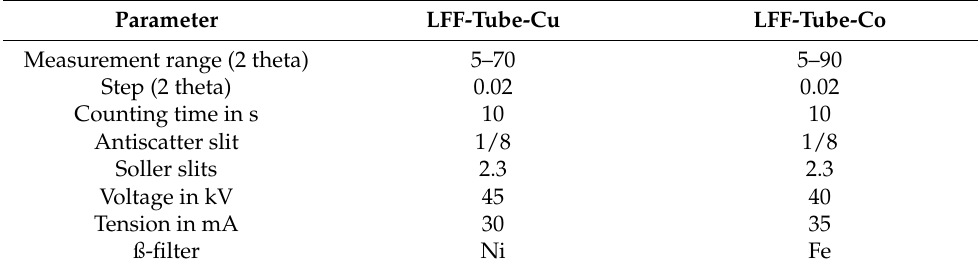
Table 2. XRD measurement parameters. (LFF = long fine focus